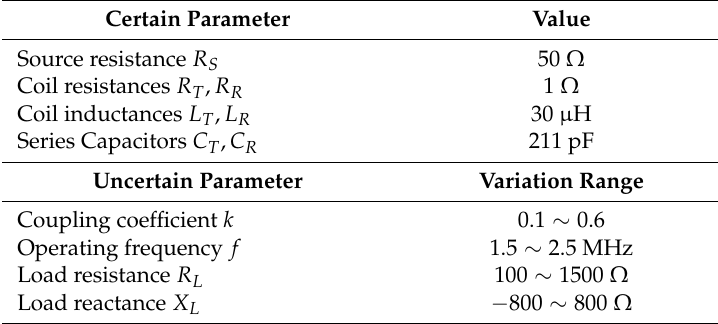
Table 2. Simulation parameters of the SS compensated WPT